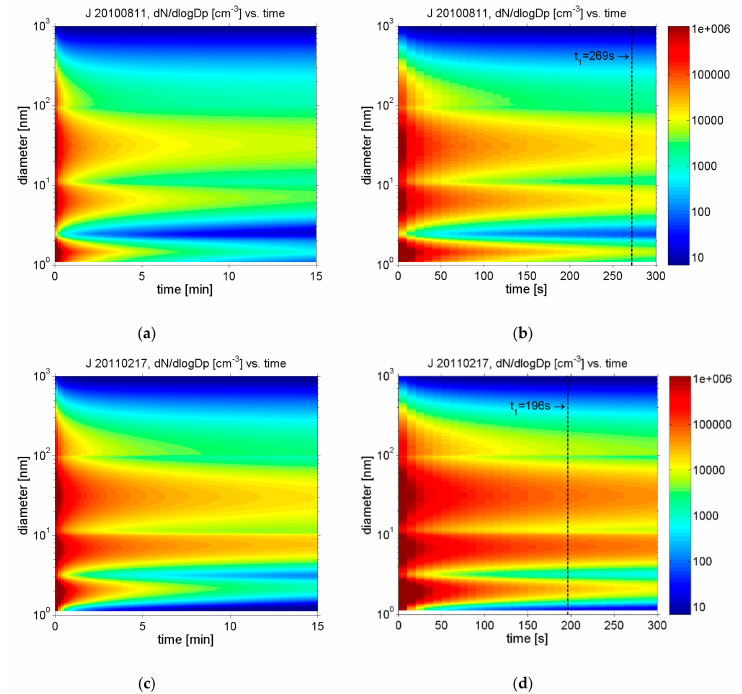
Figure 5. Modelled sequential particle size distributions in the ship plume from 1 s after release from the ship stack up to 15 min downwind (left-hand side panels) and up to 5 min downwind (right-hand side panels). Upper panels: ( a ) J_20100811 in summer, up to 15 min downwind; ( b ) J_20100811 in summer, up to 5 min downwind; lower panels: ( c ) J_20110217 in winter, up to 15 min downwind; ( d ) J_20110217 in winter, up to 5 min downwind. Vertical dashed line indicates the time at which the highest measured concentrations were recorded at Sni ff er (t 1